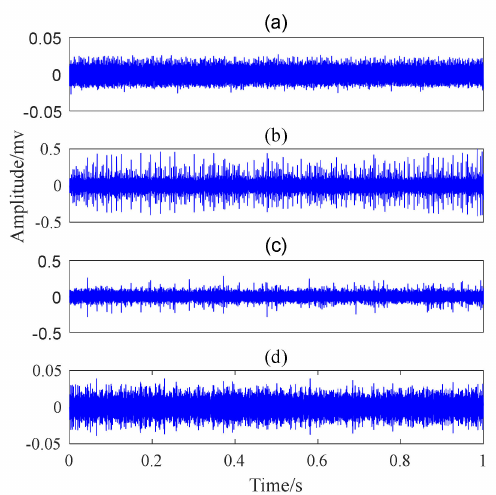
Figure 31. The collected signal of the bearing with 1 mm inner race fault and the result of the collected signal processed by the MCKD-EWT method: ( a ) the original signal; ( b ) the de-noised signal processed by MCKD method; ( c ) the spectrum of the original signal; ( d ) the Fourier spectrum segmentation result of the de-noised signal obtained by Improved EWT method.